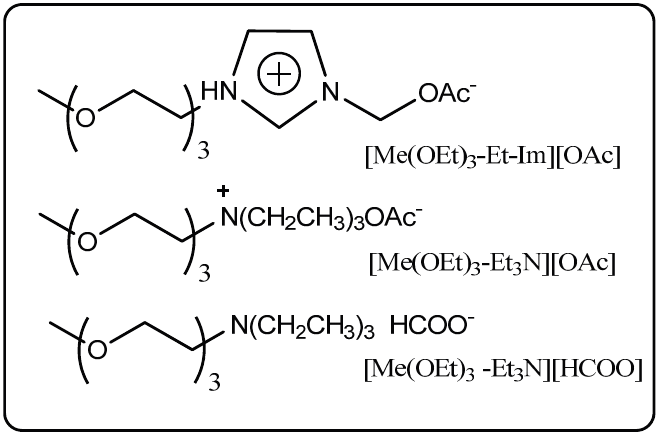
Figure 5. Novel triethyleneglycol-functionalized ionic liquids for biodiesel synthesis